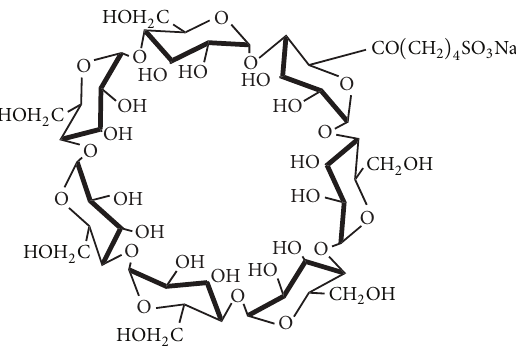
Figure 1: Structure of ( R, S )-citalopram.